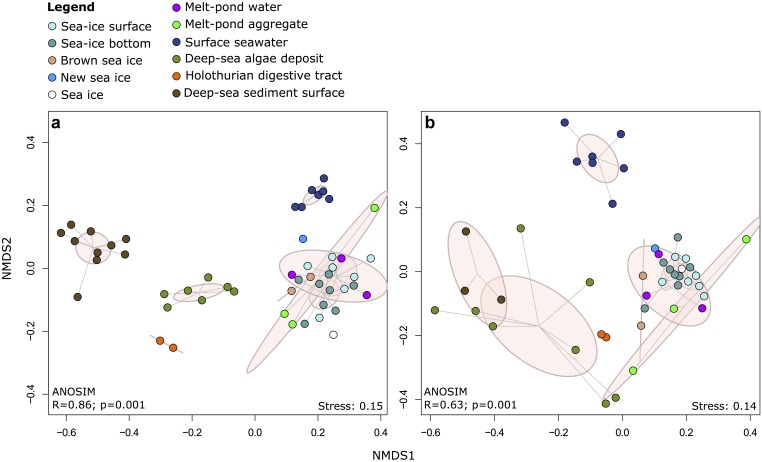
Two-dimensional NMDS ordination of community dissimilarities for (a) bacteria and (b) eukaryotes. Dissimilarity matrices and ANOSIM were calculated using the Bray-Curtis dissimilarity measure on the basis of relative abundances of Illumina OTUs. Environments are depicted by color coding and points within each environmental grouping are connected to their group centroid through a spider diagram. Pink ellipses indicate the estimated 95% dispersion limits of each group.